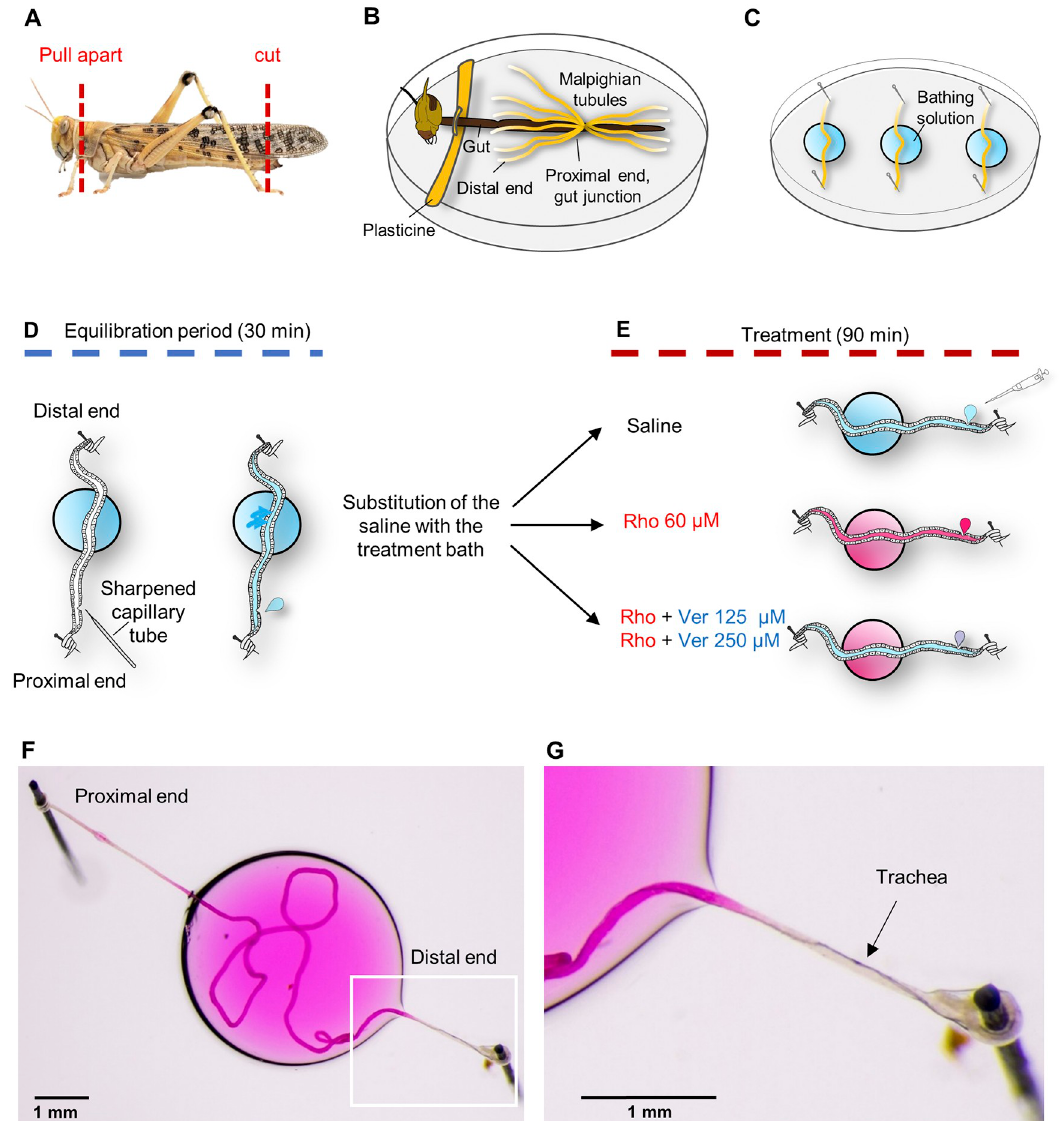
Fig 1. Preparation of Malpighian tubules for ex vivo experimentation from the desert locust, Schistocerca gregaria , and experimental scheme for assaying the presence of P-glycoproteins within the Malpighian tubules. ( A ) Cutting the posterior tip of the abdomen permits removal of the head and the fully intact gut. ( B ) The gut is submerged in saline and the Malpighian tubules are exposed. The head is separated from the saline bath by a barrier of modelling clay. ( C ) Three tubules are removed from each locust and fixed on a Sylgard 1 surface traversing a small drop of bathing solution, and covered with paraffin oil. ( D ) The proximal and distal ends of individual tubules are wound around Minuten pins to fix them. Once the saline bath and paraffin oil have been applied, the proximal end of the tubule is punctured with a sharpened capillary tube to allow fluid secretion. After 30 minutes of equilibration the saline bath was replaced by a bath containing one of the treatments. ( E ) Every 30 minutes the secreted droplet was removed, placed on the Petri dish and photographed. ( F ) An Example of an isolated Malpighian tubule to perform a modified Ramsay secretion assay. The middle section of the tubule is immersed in the bathing solution with the respective treatment, while the proximal and distal ends are fixed outside. ( G ) Detail of the distal end with the trachea visible. Only a small part of the trachea is immersed in the bath.